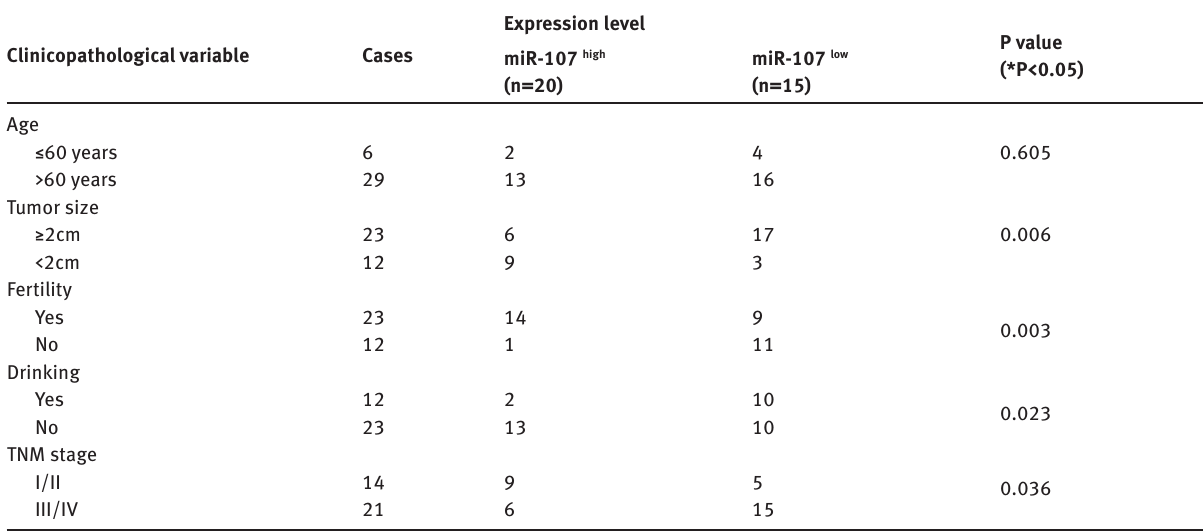
Table 1: Clinicopathological features in 35 breast cancer tumor specimens